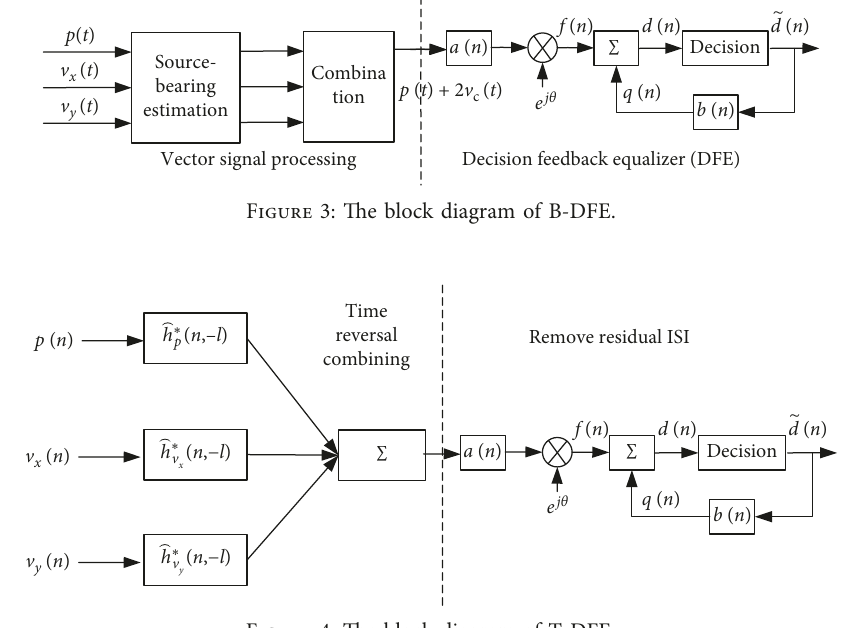
Figure 4: The block diagram of